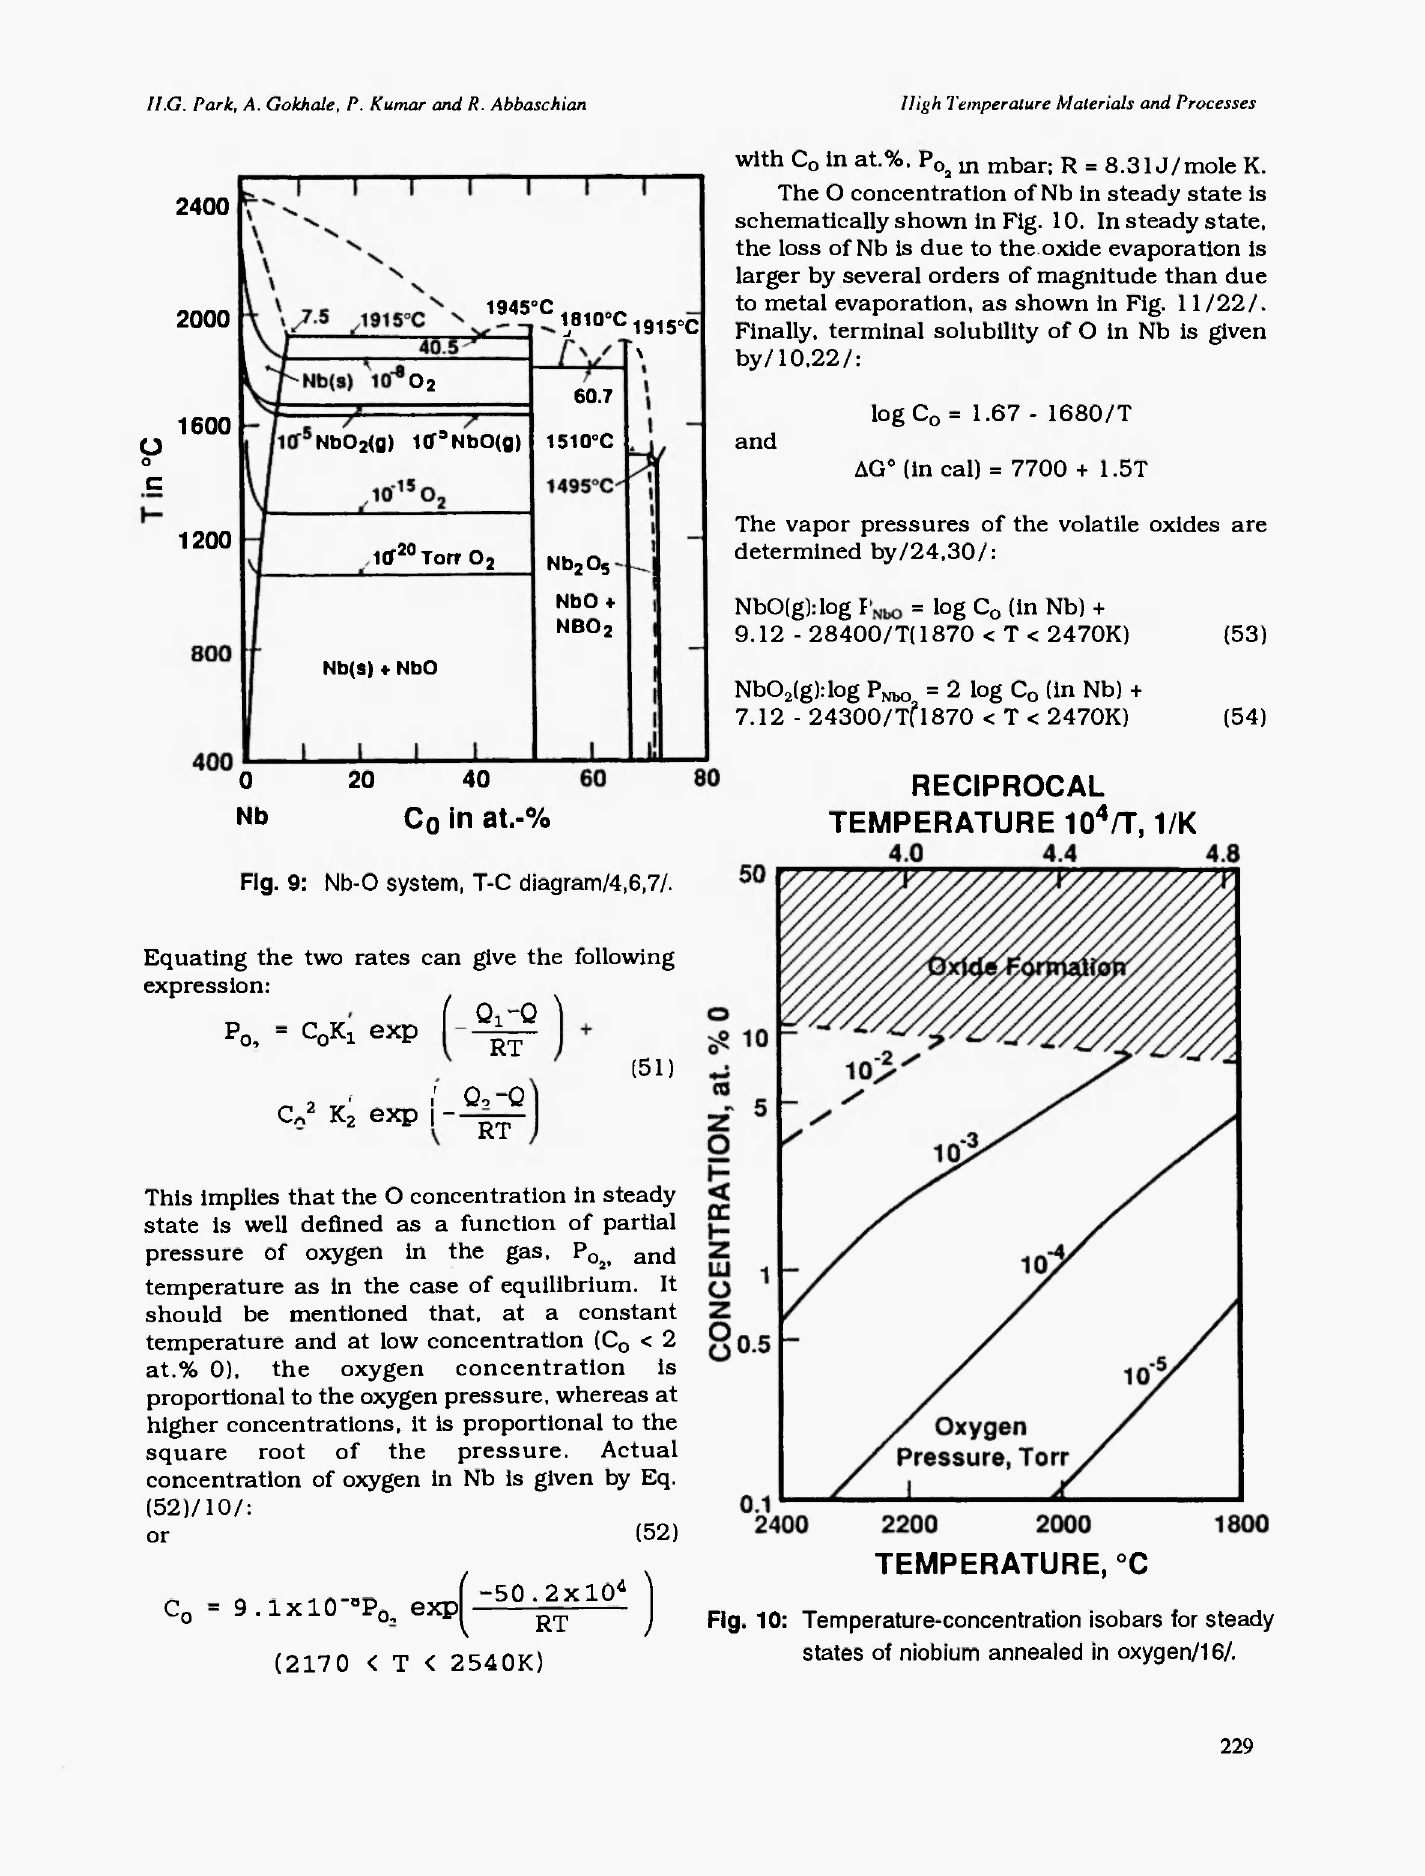
Fig. 10: Temperature-concentration isobars for steady states of niobium annealed in